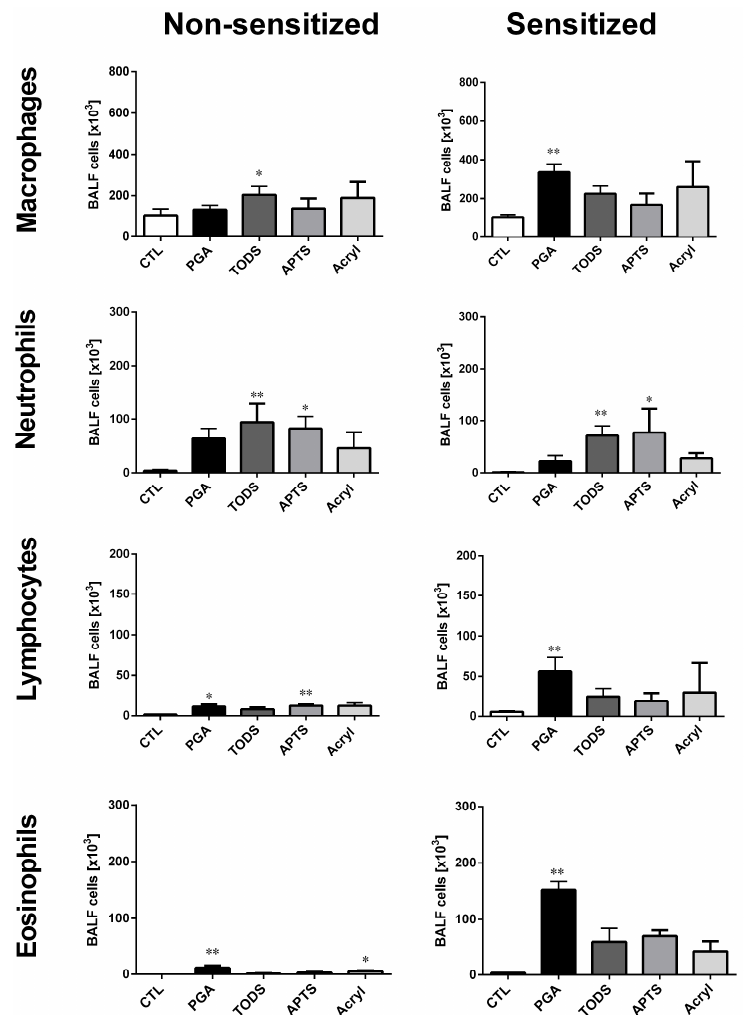
Figure 10. Effect of surface-modified ZrO 2 NPs on bronchoalveolar lavage cells of ovalbumin-sensitized and non-sensitized mice. Each group of mice ( n = 5) received 100 µ g per mouse of ZrO 2 -APTS, ZrO 2 -TODS, ZrO 2 -Acryl, or ZrO 2 -PGA prior to OVA challenge. CTL: supernatant-treated controls. * p < 0.05; ** p < 0.01 vs. CTL was revealed by one-way ANOVA followed by Kruskal-Wallis test.